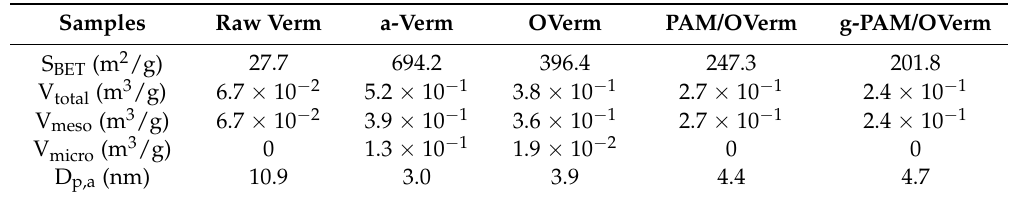
Table 2. Specific surface area (S BET ), pore volume and average pore diameter analysis of raw Verm, a-Verm, OVerm, PAM/OVerm and g-PAM/OVerm.